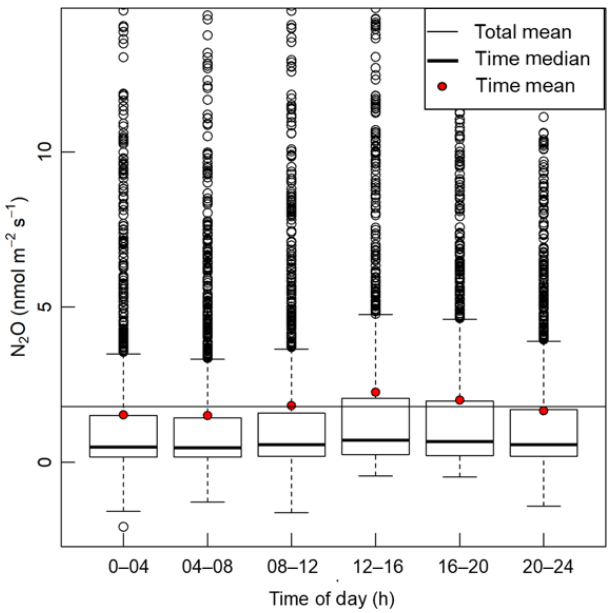
Figure 8. Boxplot of N 2 O fluxes during each 4h interval. Posi- tive outliers > 14nmolm − 2 s − 1 that comprised 1.9% of the total dataset are not shown for